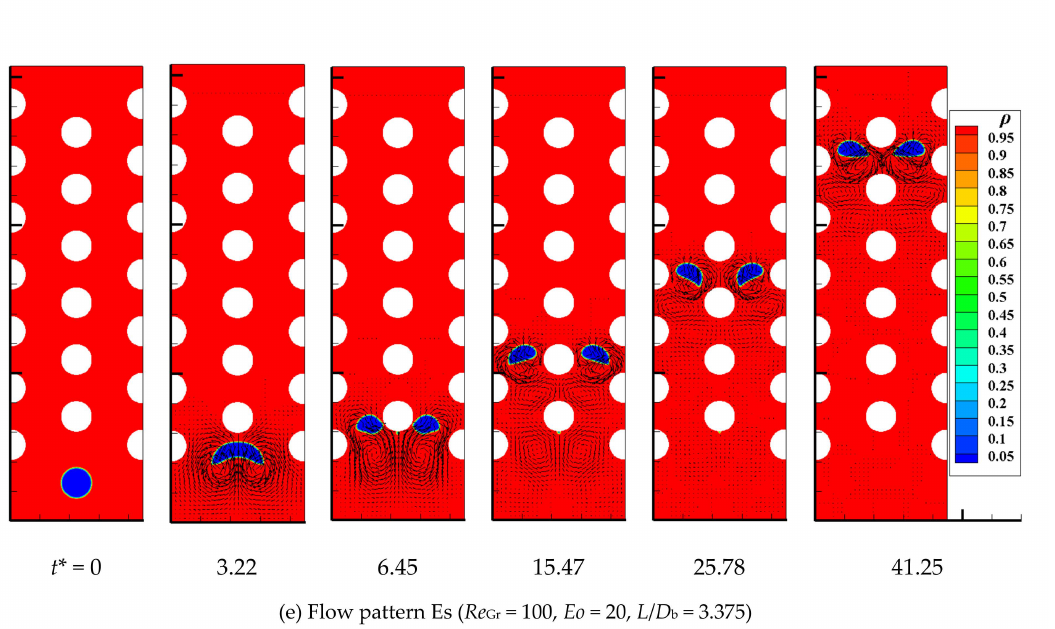
Figure 14. Bubble evolution diagrams of flow patterns As ( a ), Bs ( b ), Cs ( c ), Ds ( d ), and Es ( e ) in the S-shaped curved